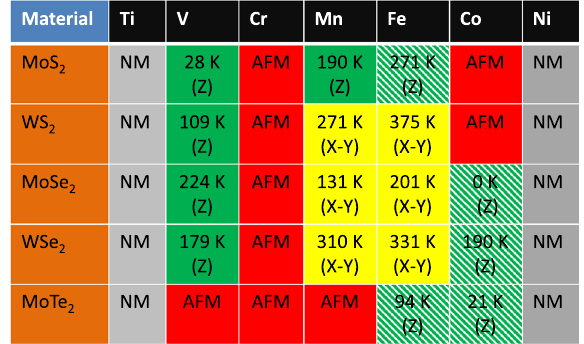
Fig. 5 Critical temperature (green for Curie and yellow for K – T) of TMDs at an atomic substitution of 15%. Shaded blocks show out- of-plane FMs with weak long-range interaction leading to clustered FM con fi magnetic easy-axis in the out-of-plane direction, while "X – Y" indicates the X – Y magnets, with an in-plane easy axis. The TMD dopant combinations, which are shaded, are clustered Z FM. Materials indicated as AFM have an anti-ferromagnetic (AFM) ordered state, while (NM) represents a non-magnetic (paramag- netic) state. As discussed above, FMs with an out-of-plane magnetic easy axis have a Curie temperature, while, FMs with an in-plane magnetic axis have a Kosterlitz-Thouless phase transition, which results in a quasi-ordered magnetic state, but the long-range order remains randomized. We provide the full atomic substitution-dependent (6% to 18%) critical temperature for all the Z and the X – Y ferromagnets in the supplementary documentation (Supplementary Table. 2).